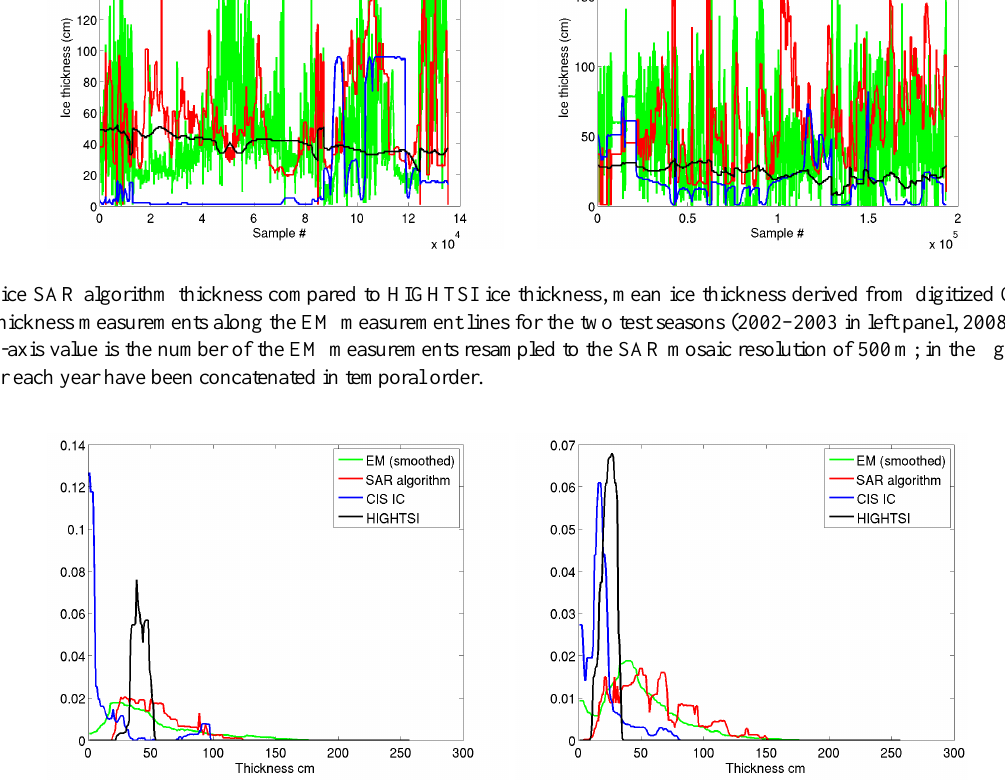
Fig. 16. The ice thickness distributions from different sources along the EM measurement lines for both the test seasons, 2002–2003 on the left and 2008–2009 on the right. Table 4. Mean ice thickness (in cm) according to different sources along the EM flight lines for the two